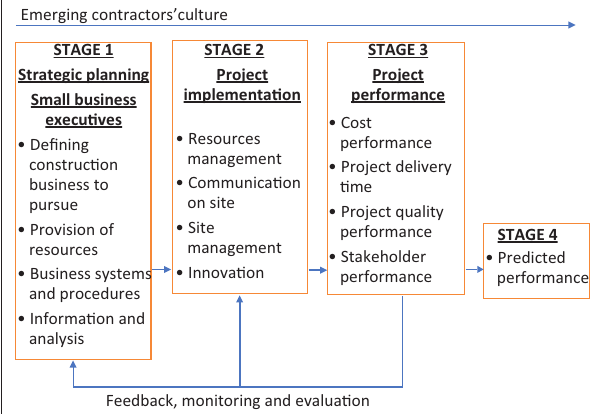
FIGURE 1: The structure of the performance prediction